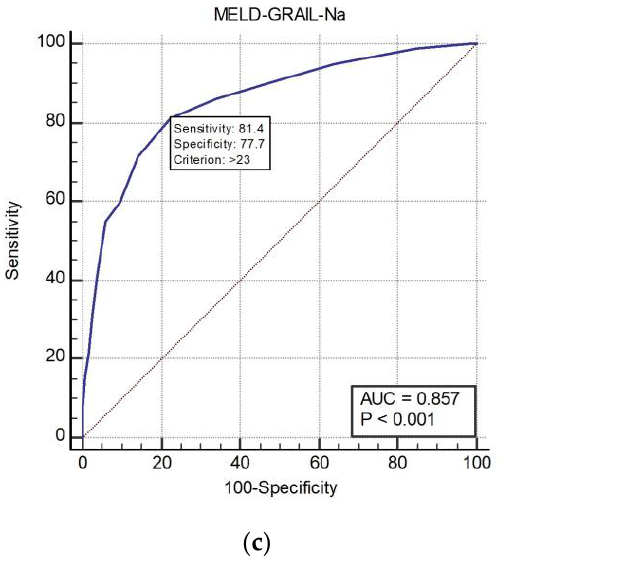
Figure 1. Receiver operating characteristic curves (ROC) and area under the ROC (AUROC) of patients with total cirrhosis for 1-month mortality. ( a ) CP score for 1-month mortality, 0.831 (95% confidence interval [CI], 0.809–0.851); ( b ) MELD for 1-month mortality, 0.847 (95% CI, 0.826–0.867); ( c ) MELD-GRAIL-Na for 1-month mortality, 0.857 (95% CI, 0.836–0.876); ( d ) comparison of AUROC for 1-month mortality between the CP, MELD, and MELD-GRAIL-Na scores.